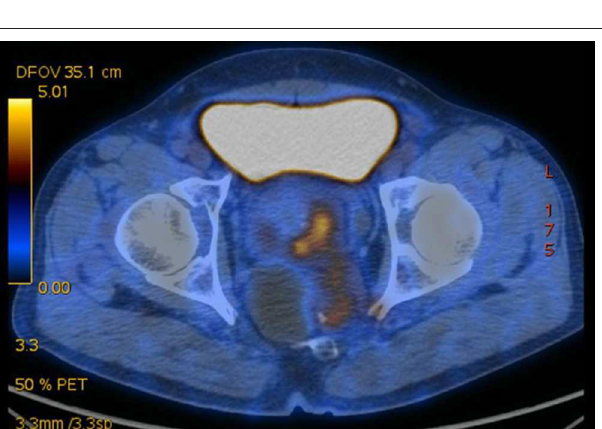
FIGURE 2 | PET-CT revealed that the rectal tumor had high FDG accumulation; the cysts did not.